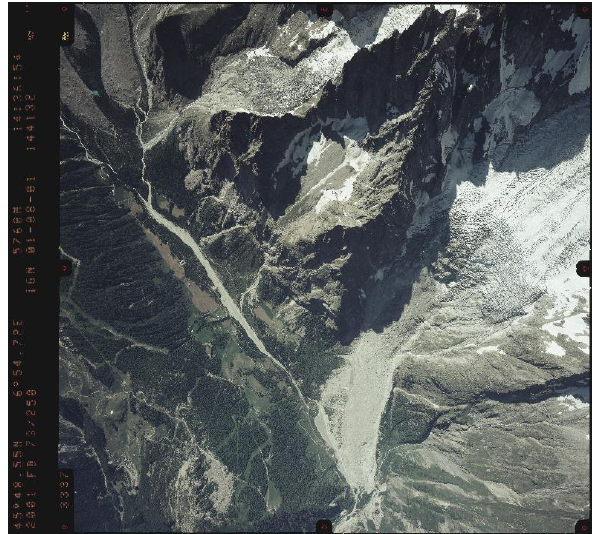
Figure. 3. An illustration of a photo from the 2001 data set with deep shadows on the Brenva Glacier close to vertical surfaces.